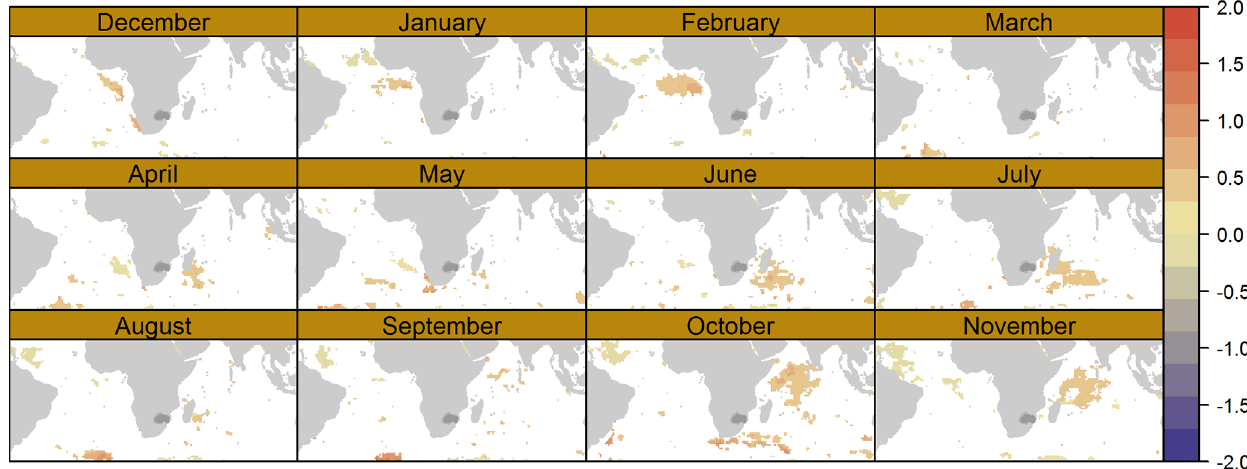
Figure 5. Composites: anomalies of sea surface temperature preceding drought during DJFMAM (significant anomalies presented only.)